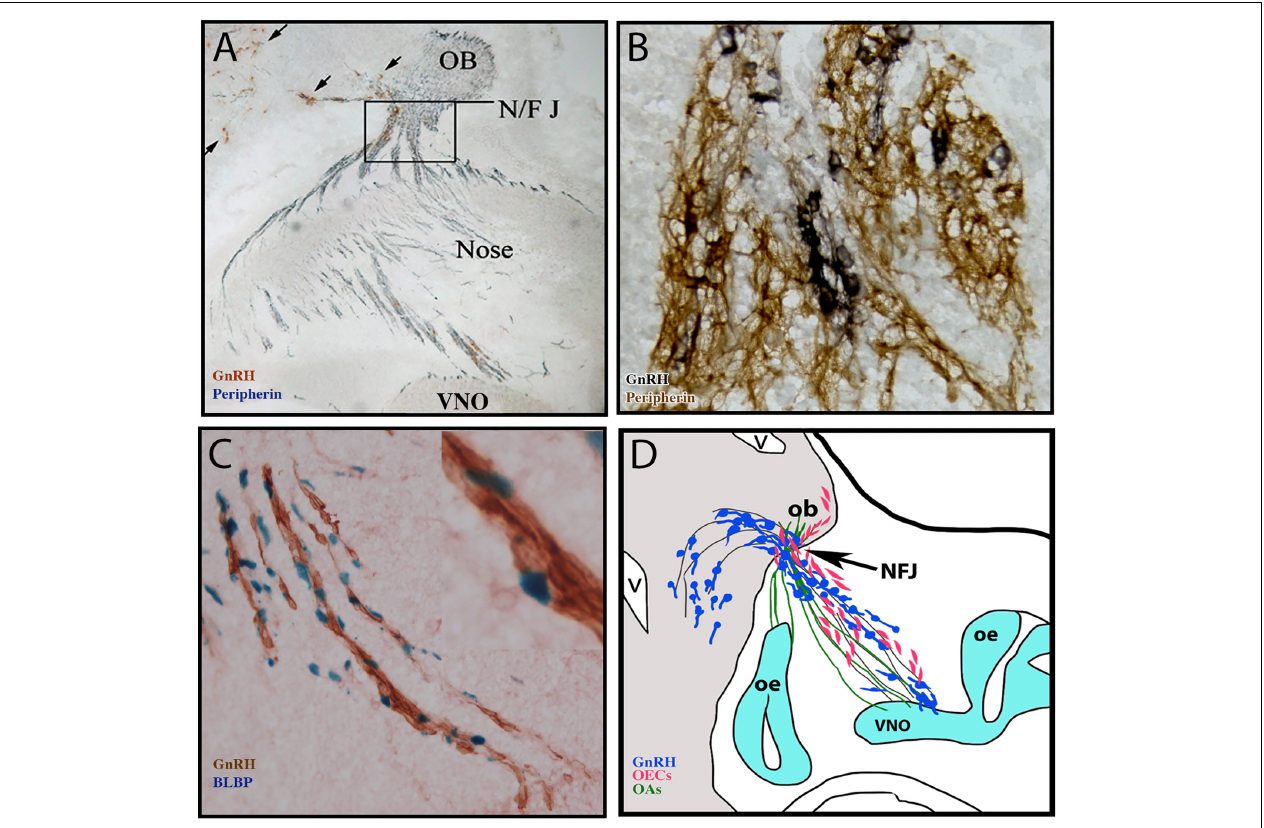
FIGURE 1 | Multiple components form the GnRH migratory bundle during development. (A) Immunocytochemistry staining of E14.5 mouse section. Brown, GnRH (black arrows); Blue, peripherin (marking olfactory axons). Axons and cells must travel through the cribriform plate at the NFJ (boxed area) (B) Immunocytochemistry staining of GnRH (black) and peripherin (brown) at the nasal forebrain junction (NF/J). (C) Staining of GnRH neurons (brown) and BLBP (blue nuclei, labeling OECs) on the migratory route. (D) Schematic of multiple components forming the GnRH migratory bundle in mouse at E14.5. GnRH neurons (blue) migrate along VNO/terminal nerve axons (black lines) into the forebrain. Other VNO sensory axons bundle with olfactory sensory axons (green) and OECs (pink) enter the olfactory